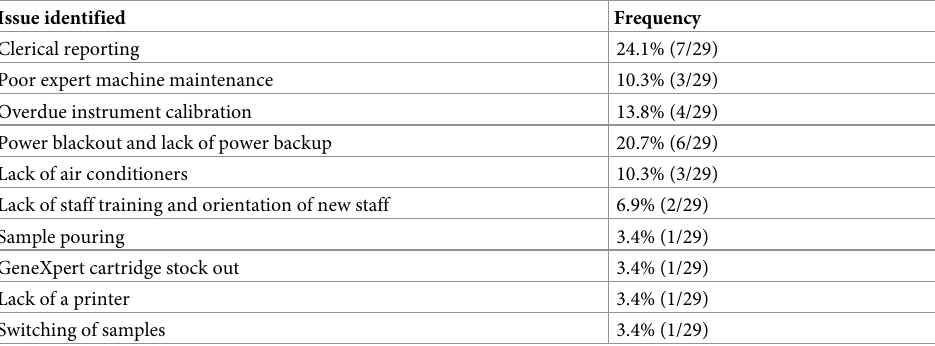
Table 6. Frequencies of issues identified during root cause analysis for laboratories with unsatisfactory